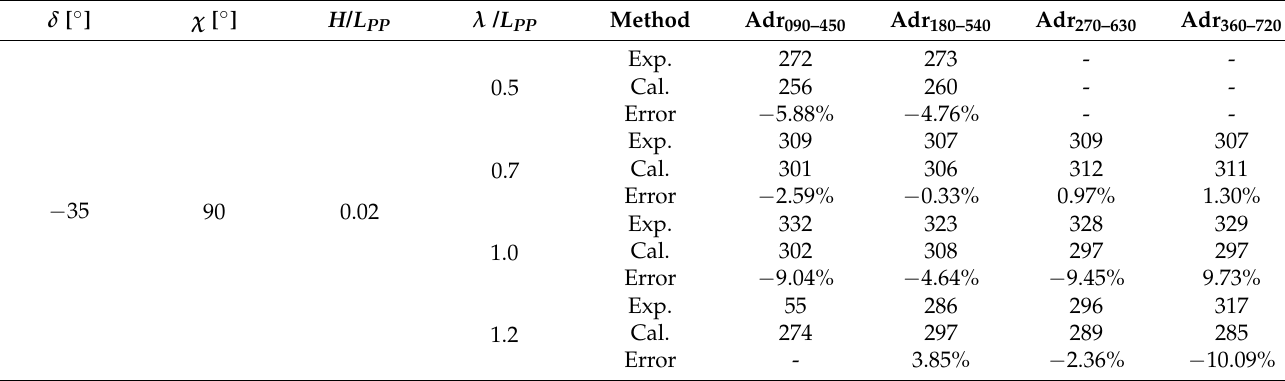
Table 7. Comparisons of trajectory drifting angle in beam waves [unit: degrees].